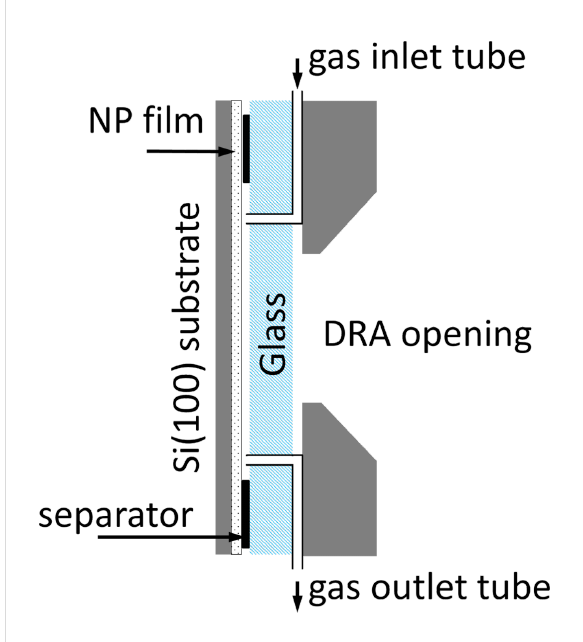
Figure 1: Construction of the flow cell for reflectance